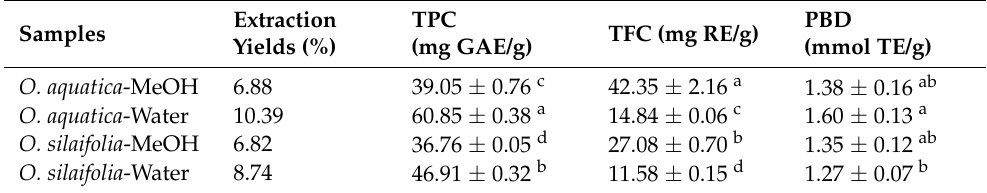
Table 1. Extraction yields, amount of biologically active substances and total antioxidant capacity (by PDA assays) of the analyzed extracts.